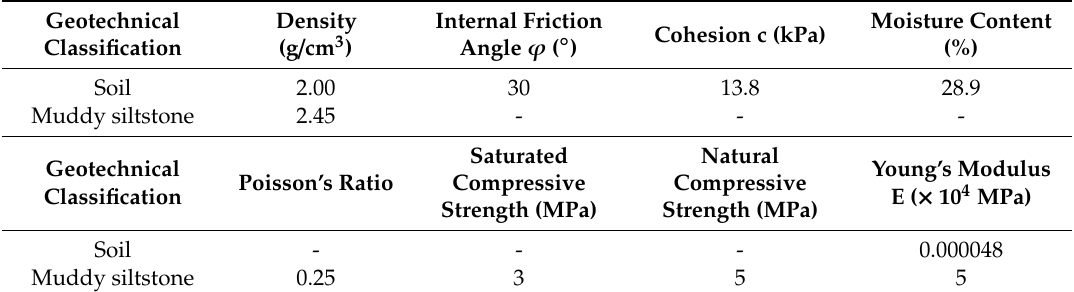
Table 2. Experimental parameters of geotechnical materials in the survey